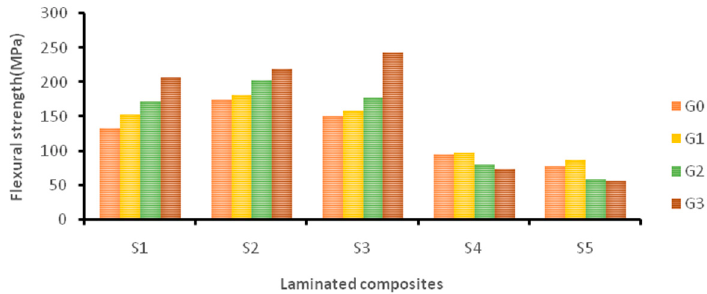
Figure 7. The e ff ect of GNP on the flexural strength of laminated Figure 7. The effect of GNP on the flexural strength of laminated composites.